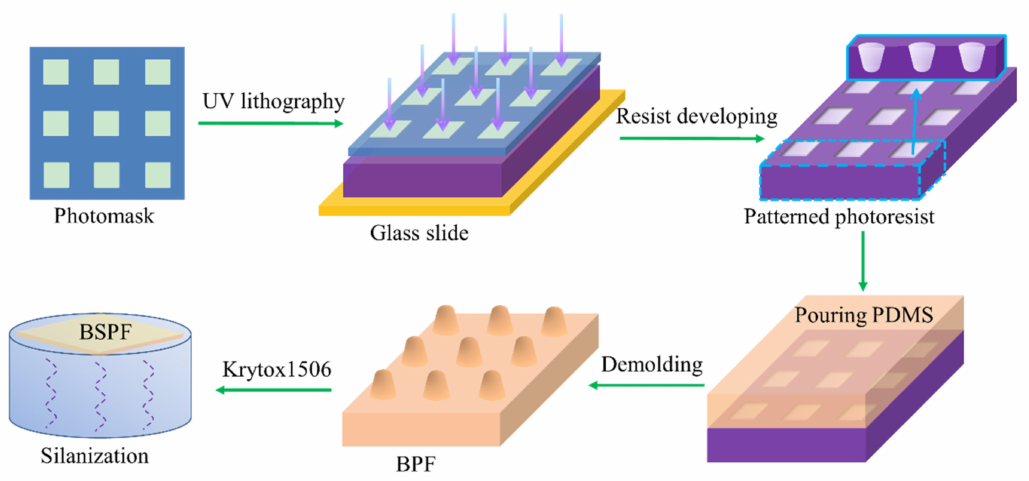
Figure 1. Schematic description for the fabrication of the BSPF surface.